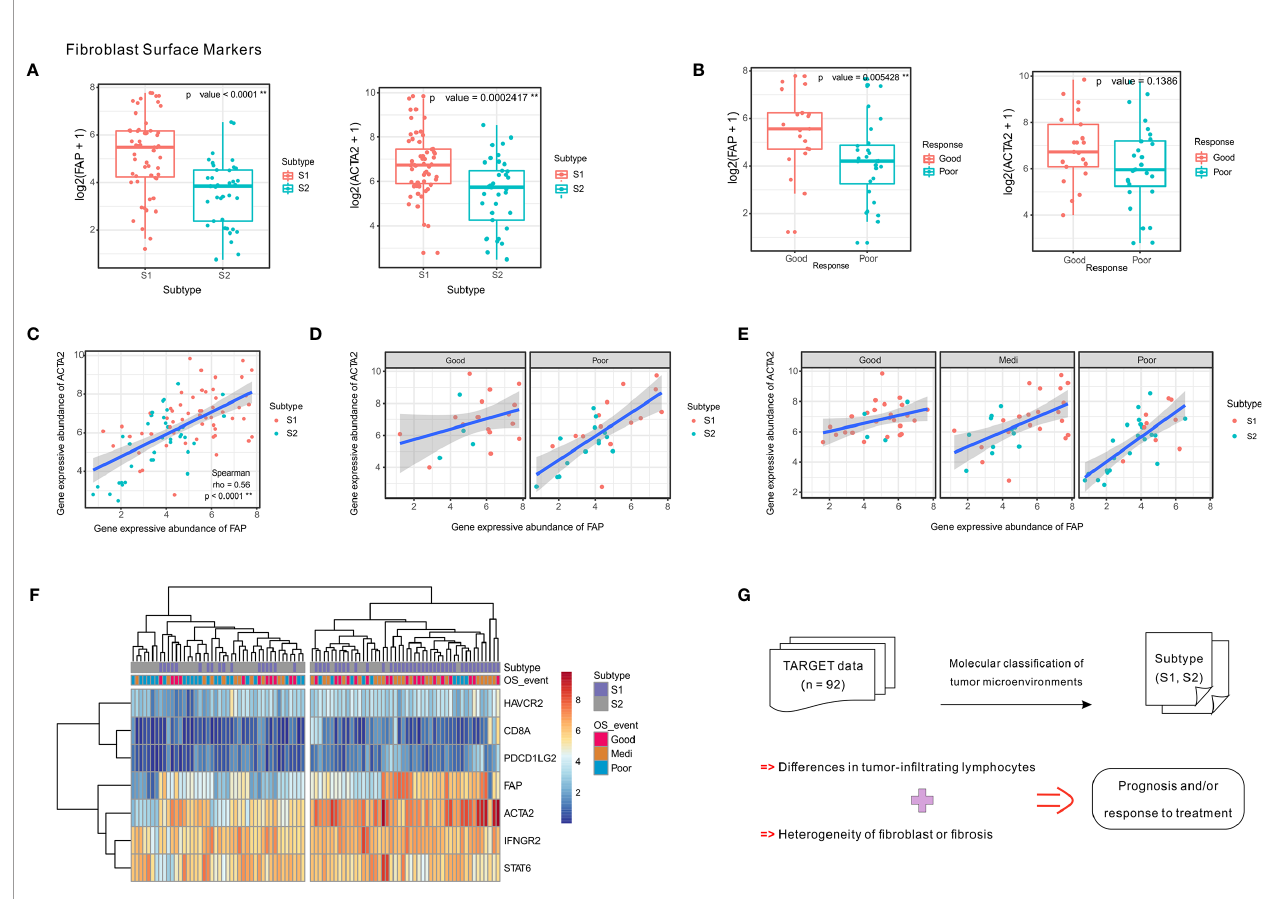
FIGURE 5 | Expression of fi broblast markers FAP and ACTA2 and their correlation with clinical response and tumor subtypes. (A) Expression levels of FAP and ACTA2 in OSA TME subtypes S1 and S2. (B) Expression levels of FAP and ACTA2 in different chemotherapeutic response events. (C – E) Spearman correlation between FAP and ACTA2 expression in whole samples, as well as different prognoses and chemotherapy responses. (F) Heatmap of FAP/ACTA2 and immune-related marker expression levels. (G) Schematic of TME heterogeneity in OSA subtypes S1 and S2. The signi fi cance levels of the p-values are presented as **p <